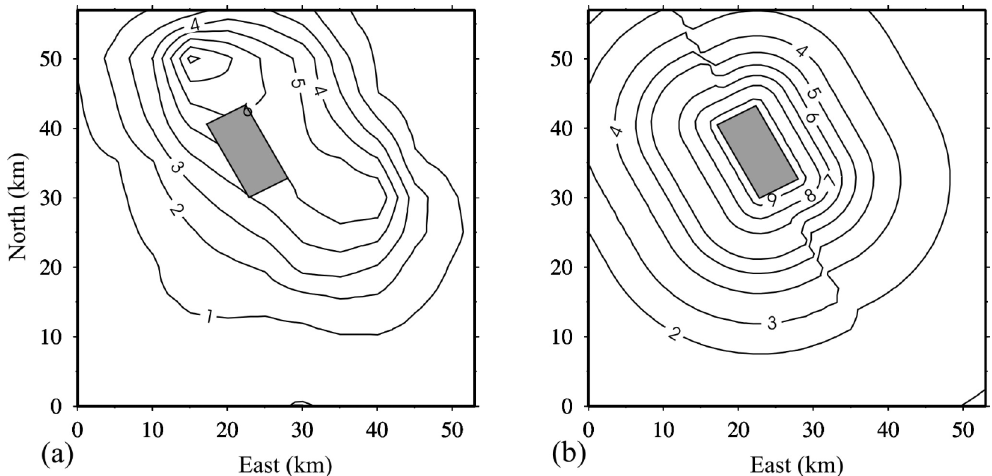
Fig. 10. Hazard map for PGA associated with the Colfiorito fault and corresponding to T=50,000 return peri- od. Contour lines for PGAs larger then 1 m/s 2 are shown. The grey rectangles represent the surface projection of the fault. (a) Hazard map for the characteristic earthquake model and PGAs simulated by the ASM technique. (b) Hazard map for the characteristic earthquake model and PGAs estimated by the Abrahamson and Silva (1997) predictive relation. (modified after Convertito et al .